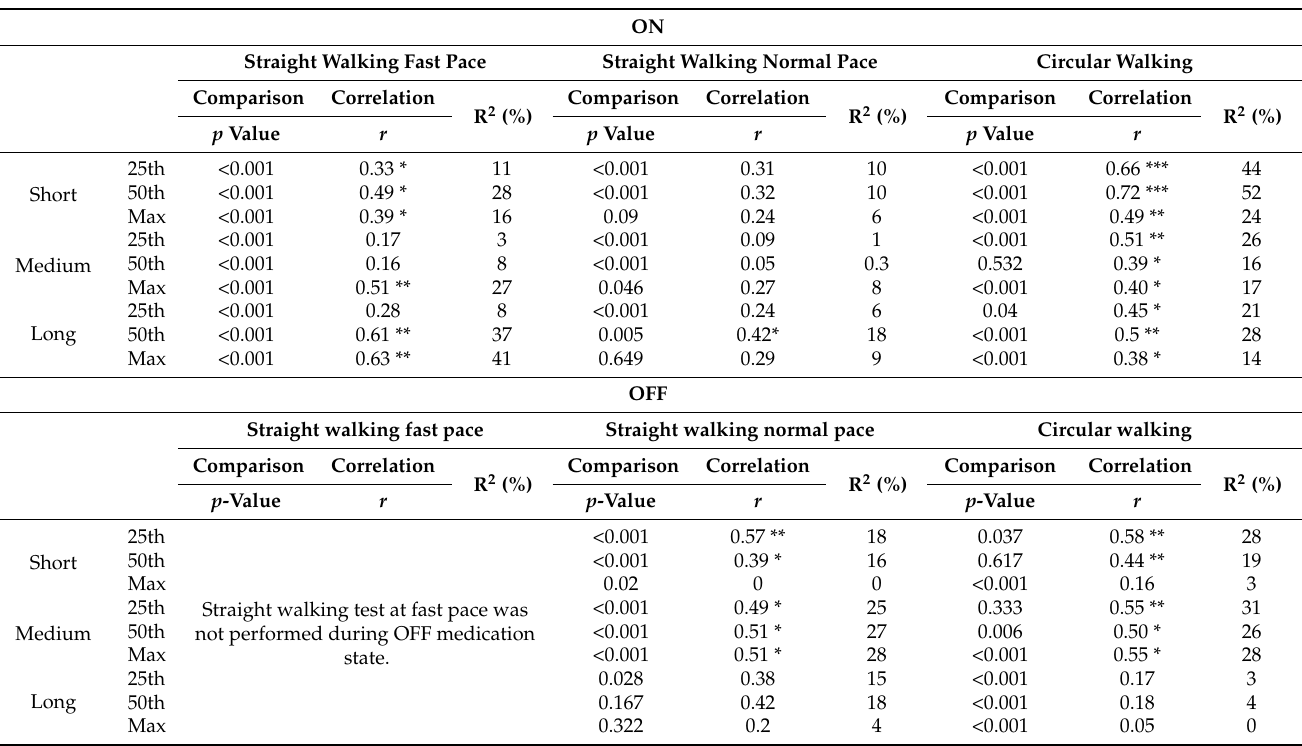
Table 3. Correlation of ON and OFF/not-ON medication states between the lab and the domestic environment according to